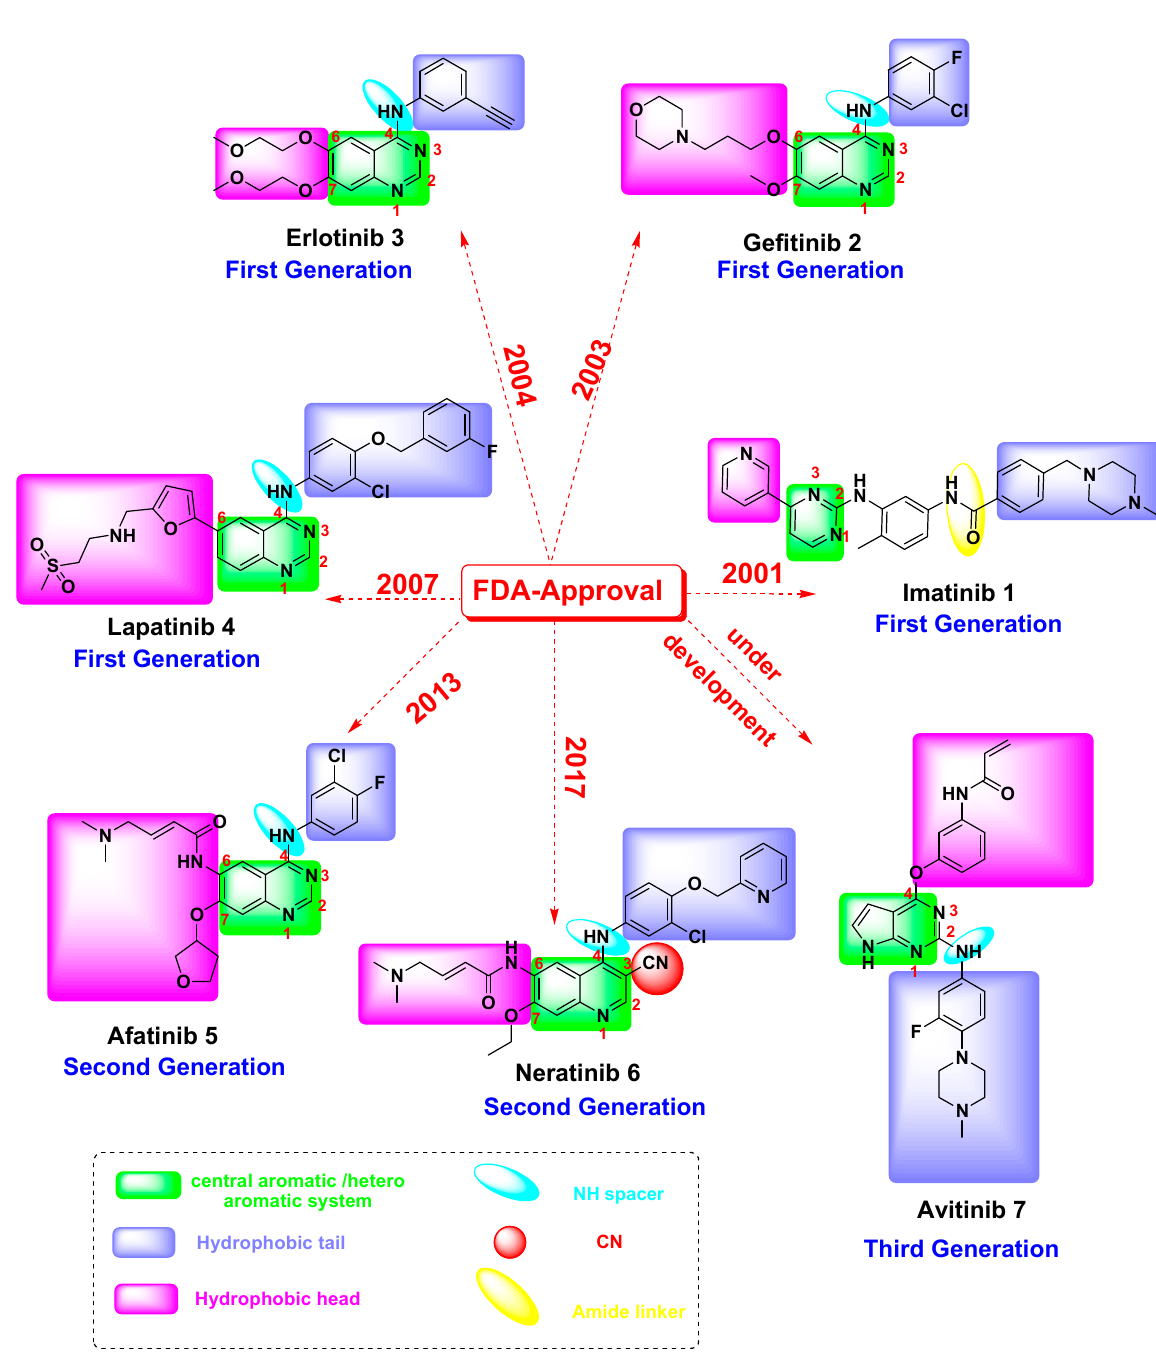
Figure 1. Representation of chemical structures of first-, second-, and third-generation tyrosine kinase inhibitors (TKIs). Recently, it has been proposed that HER2/EGFR heterodimers or HER2/HER2 ho- modimers trigger a cascade of signal transduction pathways that are responsible for tu- mor invasion, progression, and metastasis. Therefore, dual EGFR/HER2 inhibition could be more effective than individual EGFR or HER2 inhibition [13]. In view of this, and in continuing the ongoing strategy aimed at developing new scaffolds for the discovery of